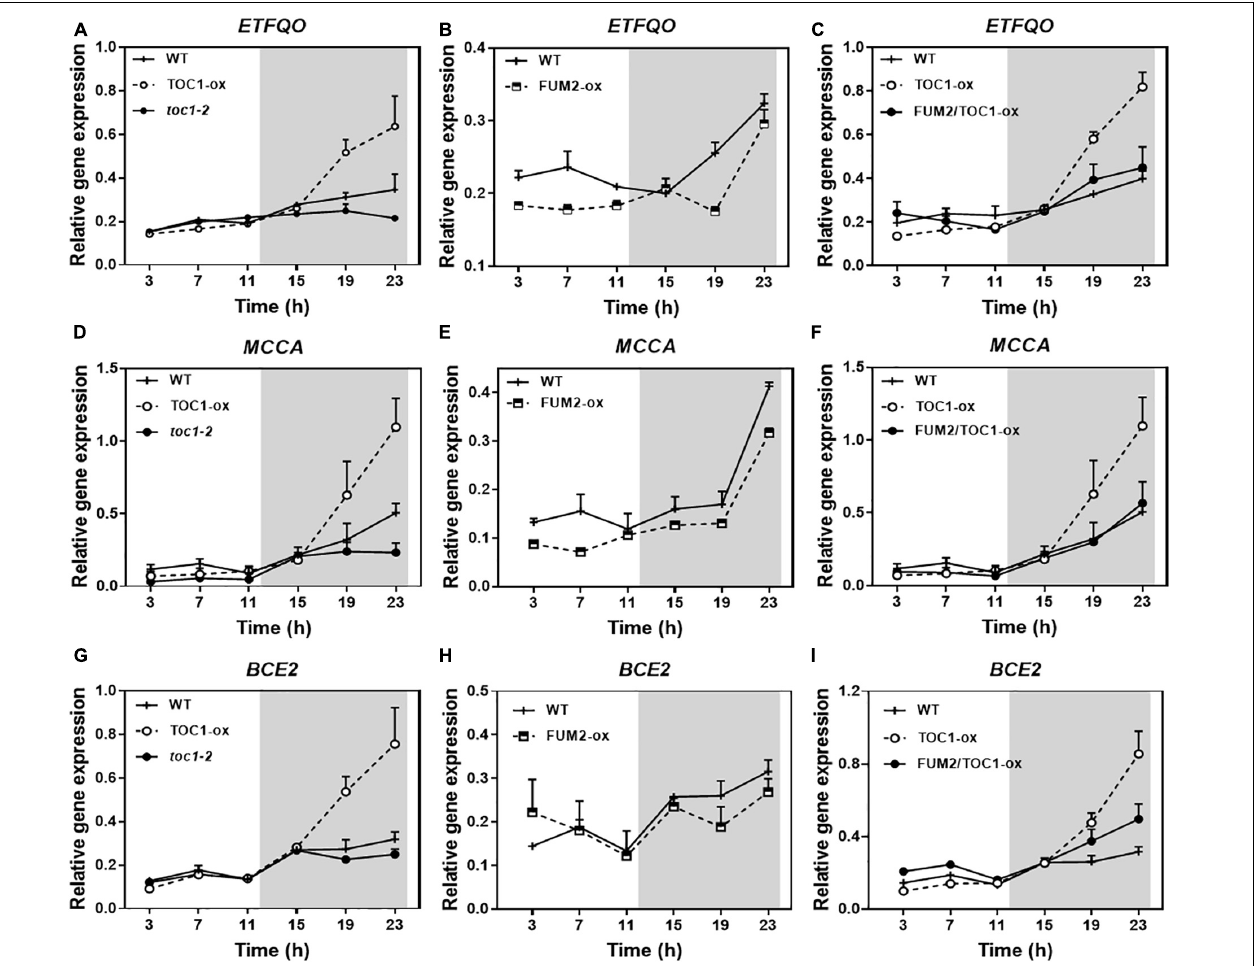
FIGURE 7 | Genetic interaction studies of the molecular signatures showing energy deprivation. Time course analysis by RT-QPCR of (A–C) ELECTRON-TRANSFER FLAVOPROTEIN: UBIQUINONE OXIDO-REDUCTASE ( ETFQO ), (D–F) METHYLCROTONYL-COA CARBOXYLASE ( MCCA ) and (G–I) DARK INDUCIBLE 3 ( BCE2/DIN3 ) gene expression in the indicated genotypes grown under LD cycles. Data are represented as the mean + SEM. The white and gray areas represent day and night, respectively. Some data are repeated in different graphs to facilitate the comparisons among genotypes. Two (FUM2-ox) and three (WT, TOC1-ox, toc1-2 , and FUM2/TOC1-ox) biological replicates were performed, with plants grown independently, with samples collected, processed and analyzed at different